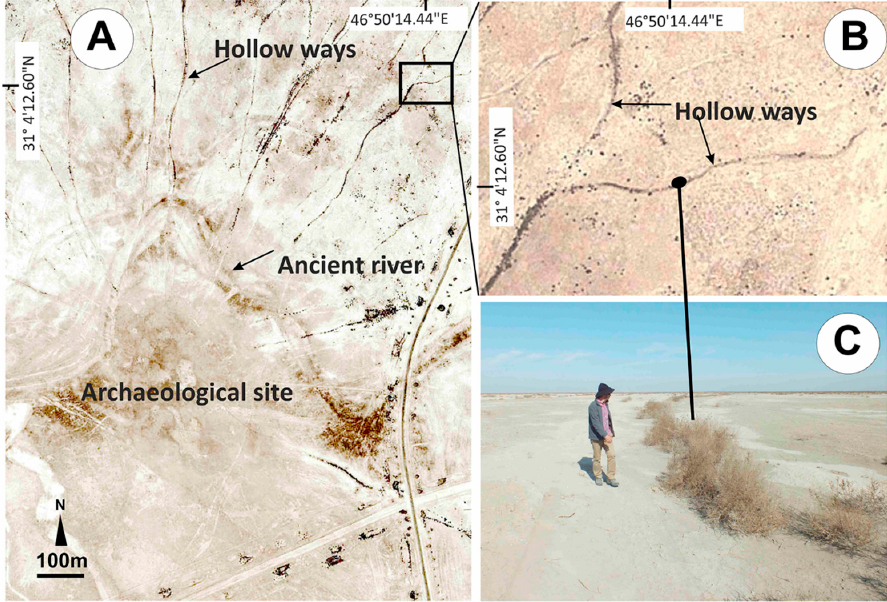
Figure 5. Ground-truthing a potential hollow way in Southern Mesopotamia. Its shallow depth and lack of levees confirm the feature’s identification as a hollow way ( A – C.